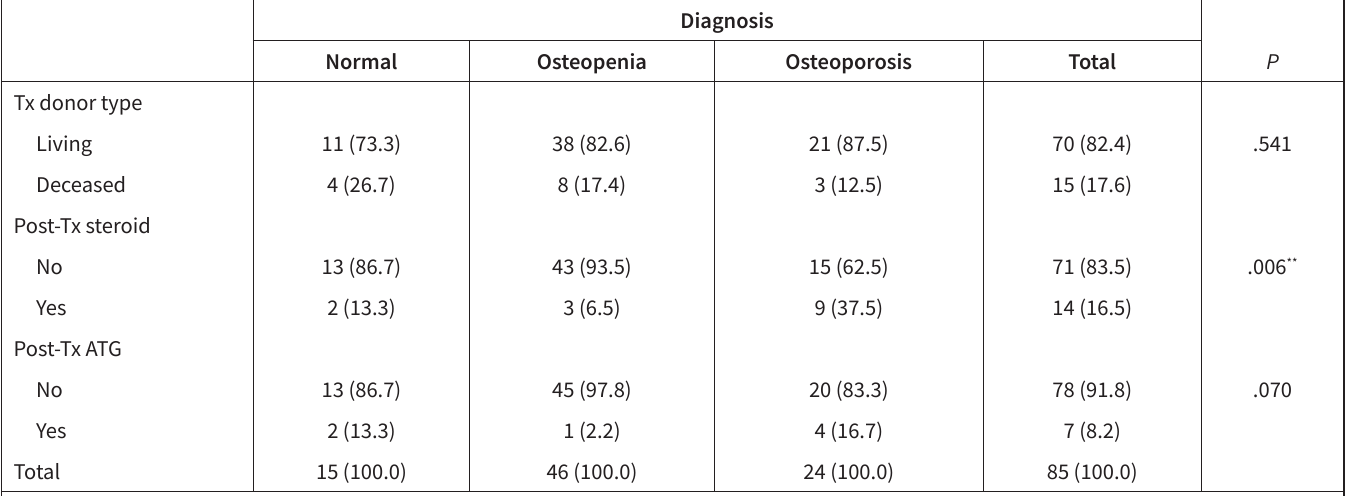
Table 2. Distribution of Steroid and ATG Use Status After Donor Type and Renal Tx According to Study